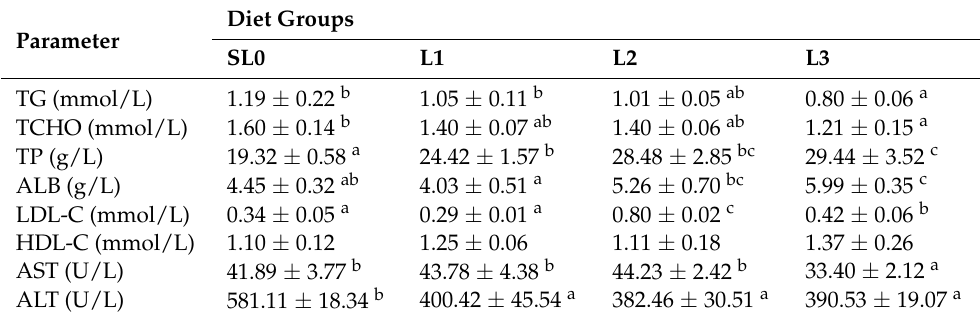
Table 4. Effect of diet supplementation with α -LA on the serum biochemical indexes of juvenile hybrid